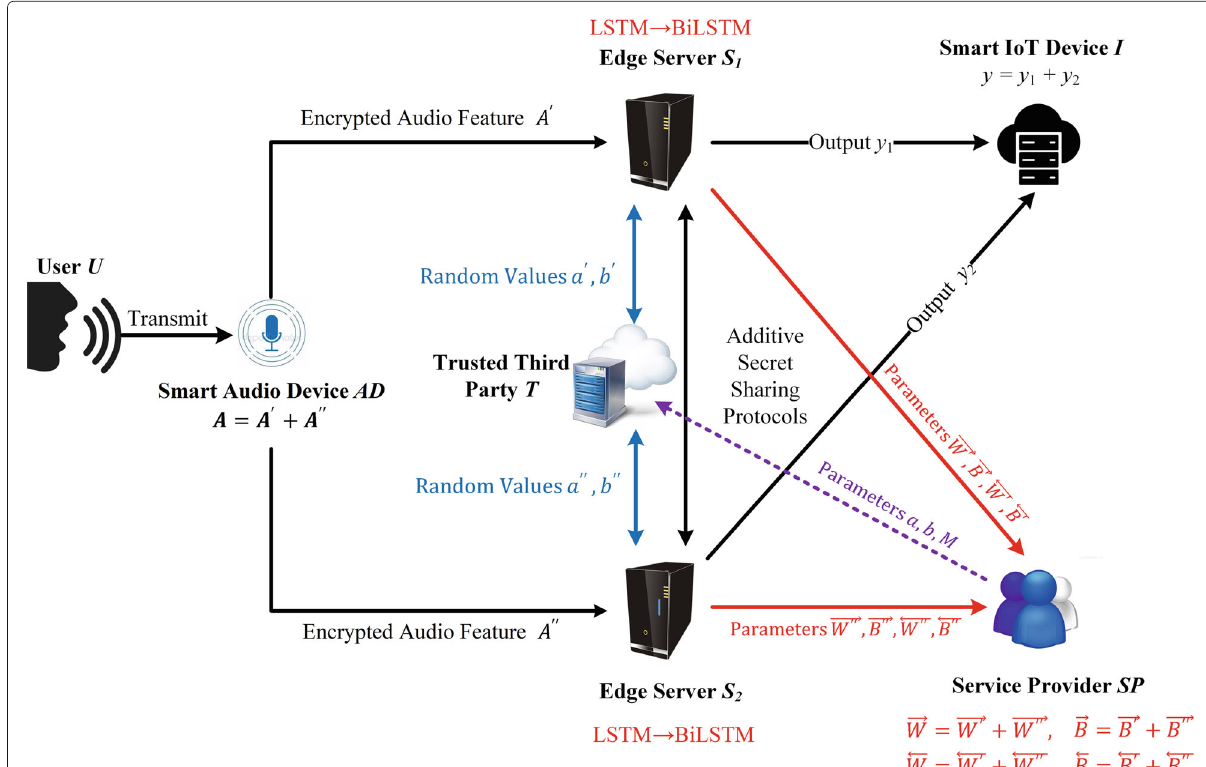
Fig. 1 The architecture of the framework